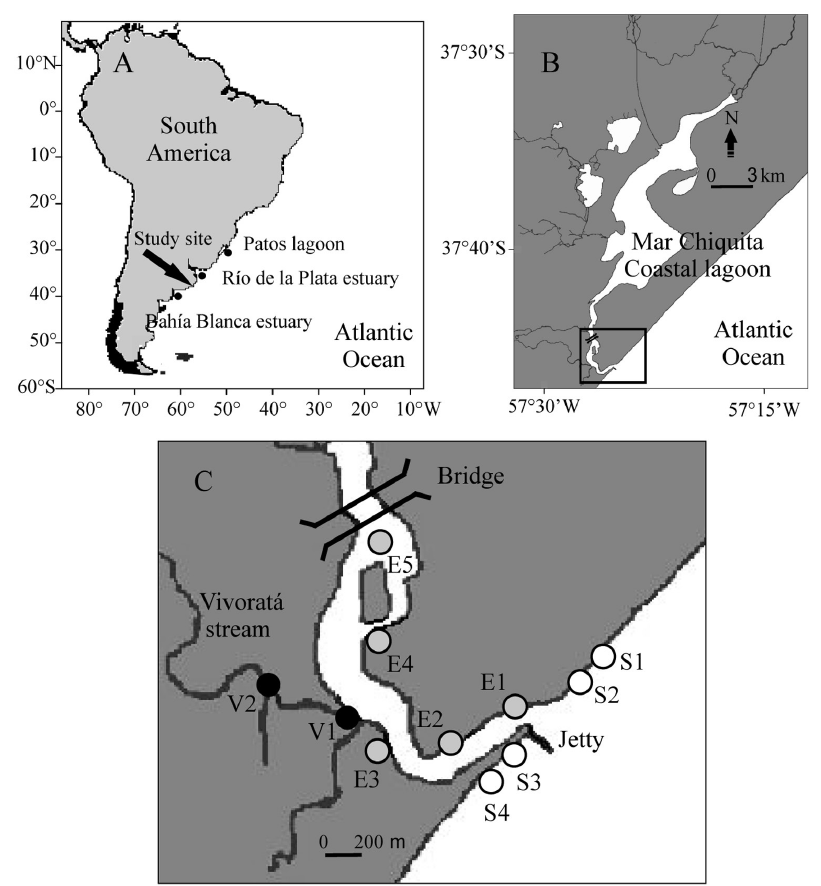
Fig. 1. – Map of the study site. A, location of Mar Chiquita coastal lagoon (Argentina) in South America and the main nearby estuarine systems; B, the area of Mar Chiquita coastal lagoon under study; and C, location of the sampling stations in the surf zone (S1-S4), the estuary zone (E1-E5) and the Vivoratá stream